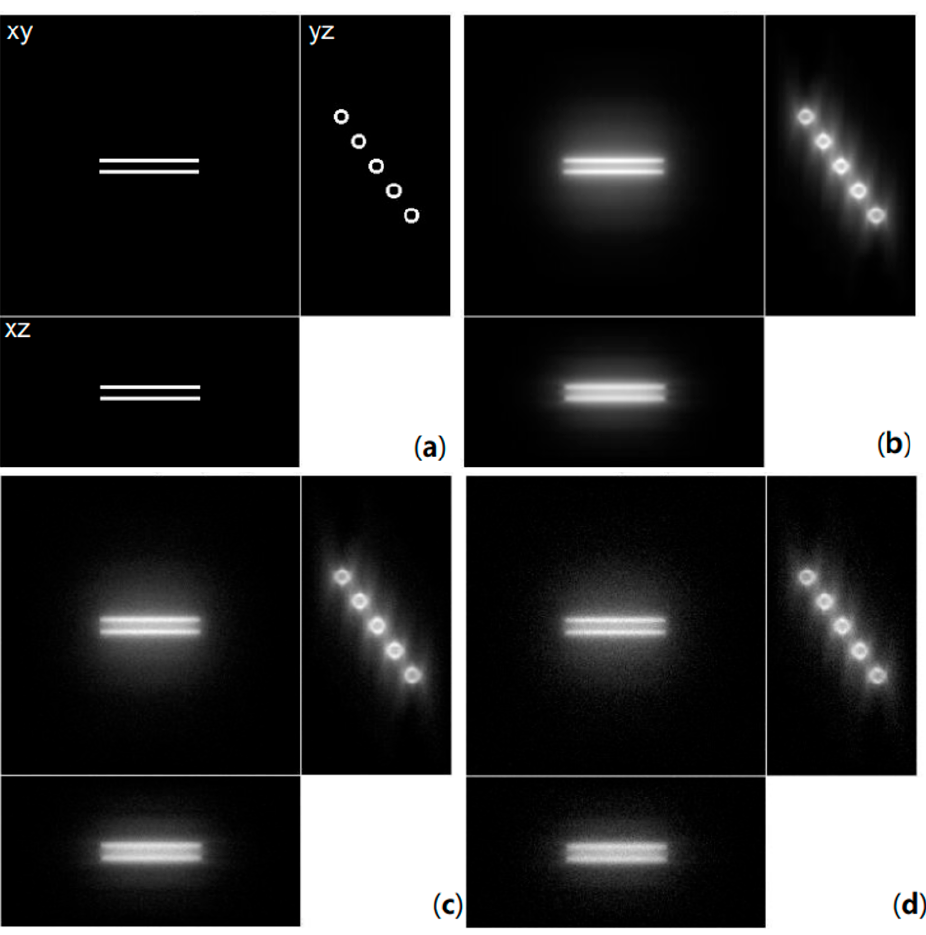
Figure 5. Dataset for DVDeconv evaluation: ( a ) Original image, ( b ) blurred image, and blurred image with ( c ) 15 dB and ( d ) 10 dB Gaussian noise under a Poisson distribution.